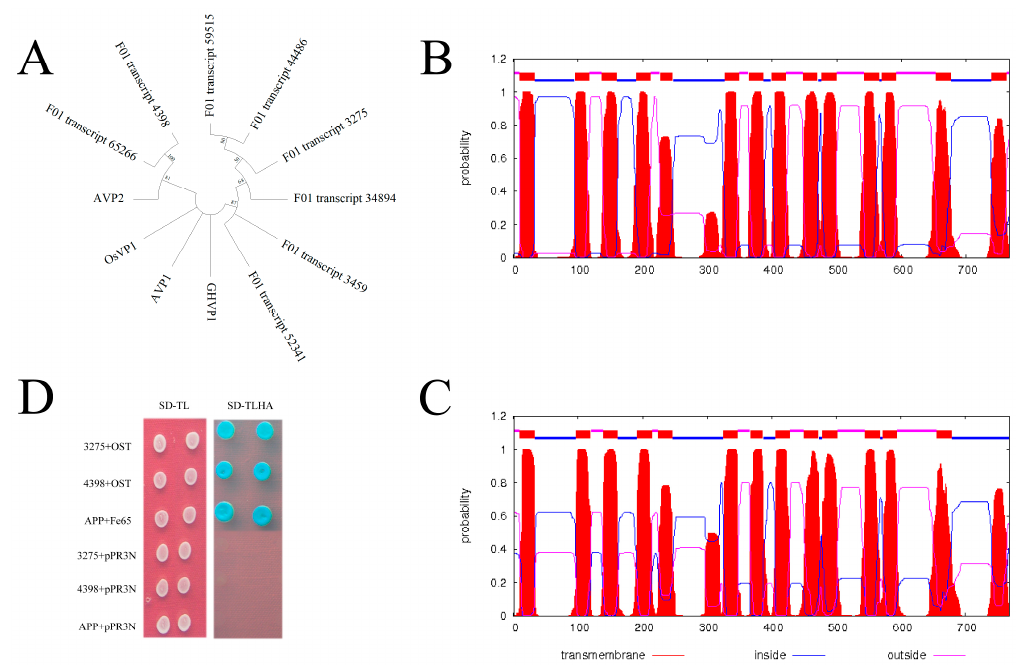
Figure 10. ( A ) Phylogenetic analysis of H + -PPase genes. ( B , C ) H + -PPase transmembrane helix-domain prediction by TMHMM. ( D ) Function analysis by DUAL membrane system, 3275: F01_Transcript_3275-pBT-3N; 4398: F01_Transcript_4398-pBT-3N; OST: positive prey control vector, pOst1-NubI; pPR3N: empty prey vector; Fe65: positive prey vector, pNubG-Fe65; APP: positive bait vector,